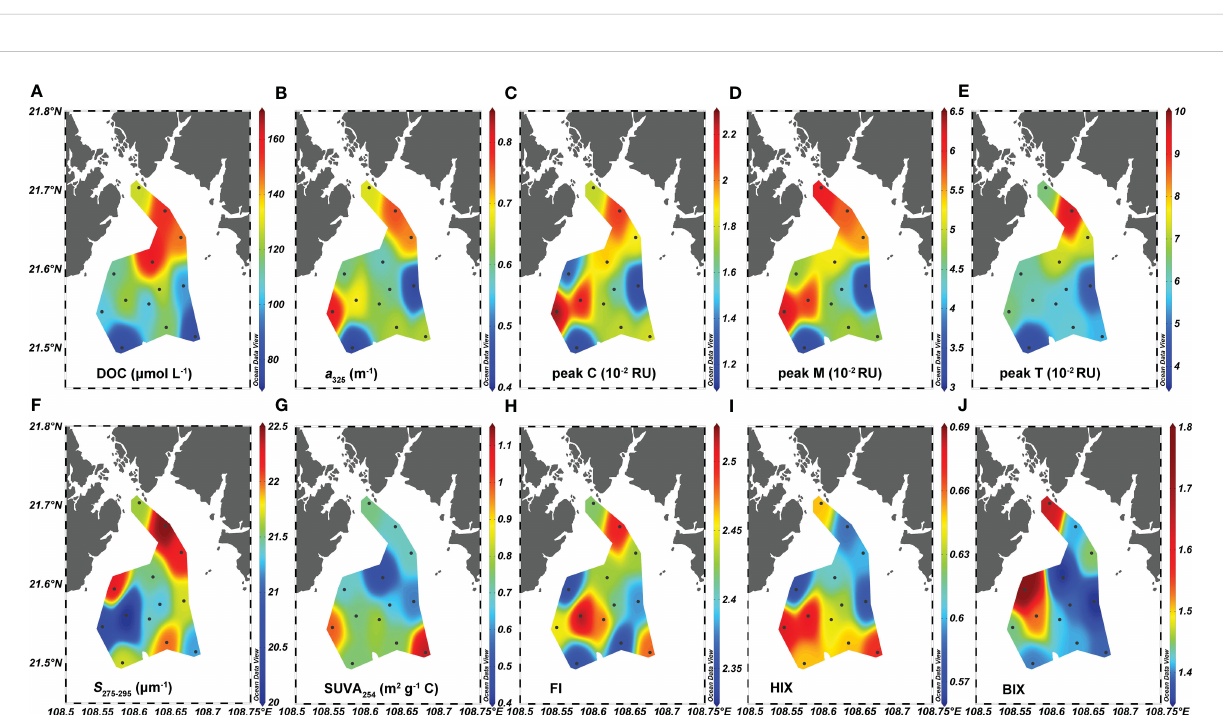
FIGURE 3 Distributions of (A) dissolved organic carbon (DOC), (B) absorption coef fi cient at 325 nm ( a 325 ), (C) peak C, (D) peak M, (E) peak T, (F) spectral slope ( S 275-295 ), (G) speci fi c ultraviolet absorbance at 254 nm (SUVA 254 ), (H) fl uorescence index (FI), (I) humi fi cation index (HIX), and (J) biological index (BIX) in the surface water of Qinzhou